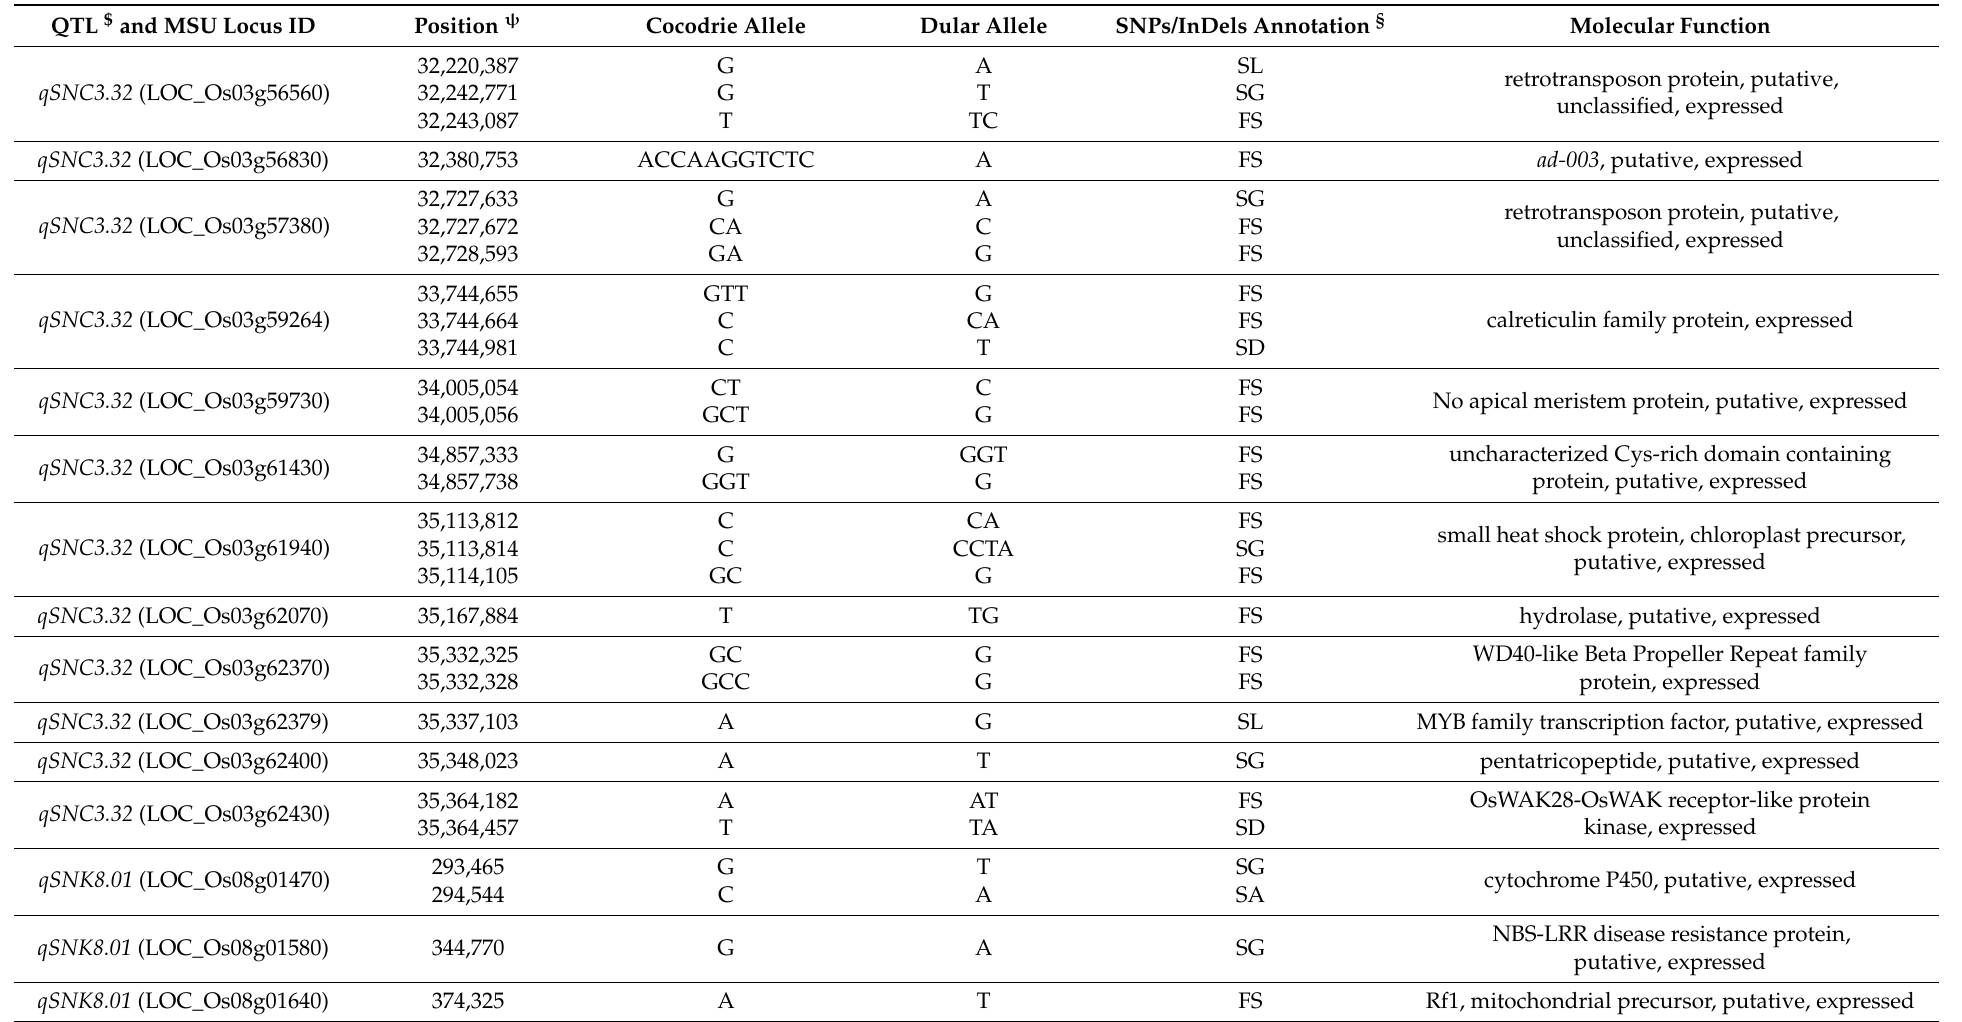
Table 6. List of polymorphic high impact SNPs and InDels in the genomic regions of selected additive